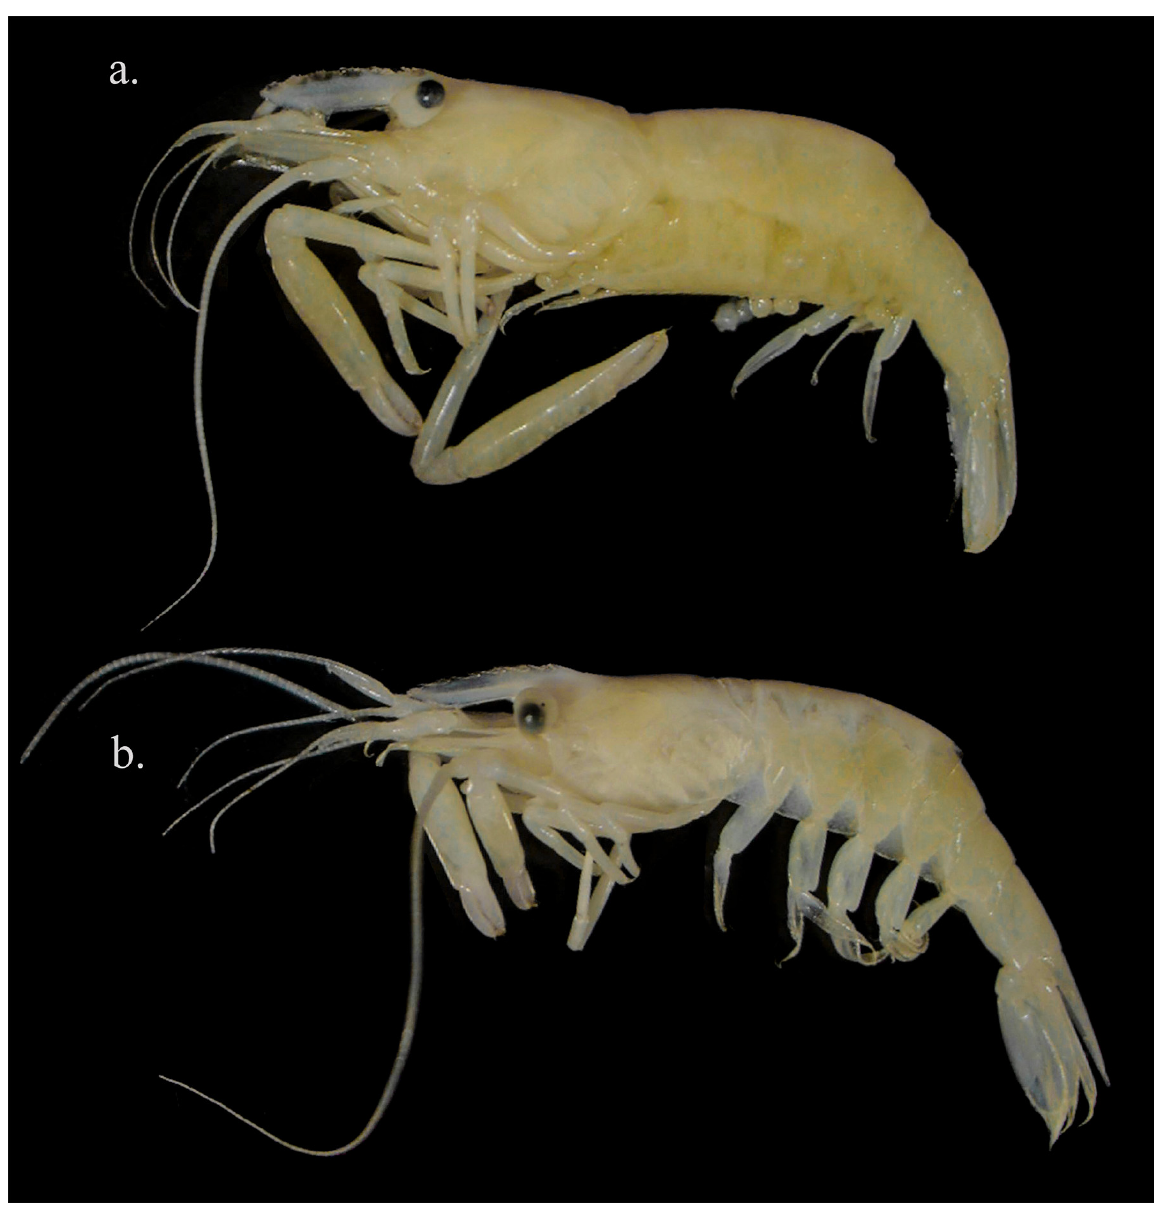
Figure 2. Actinimenes koyas sp. nov. from Agatti island, India. ( a ) Holotype: ovigerous female (CL 3.5 mm, NBFGR/PALAKOY ─ 01); (b ) paratype, male (CL 3.2 mm, NBFGR: DBTLDA62, Ethanol